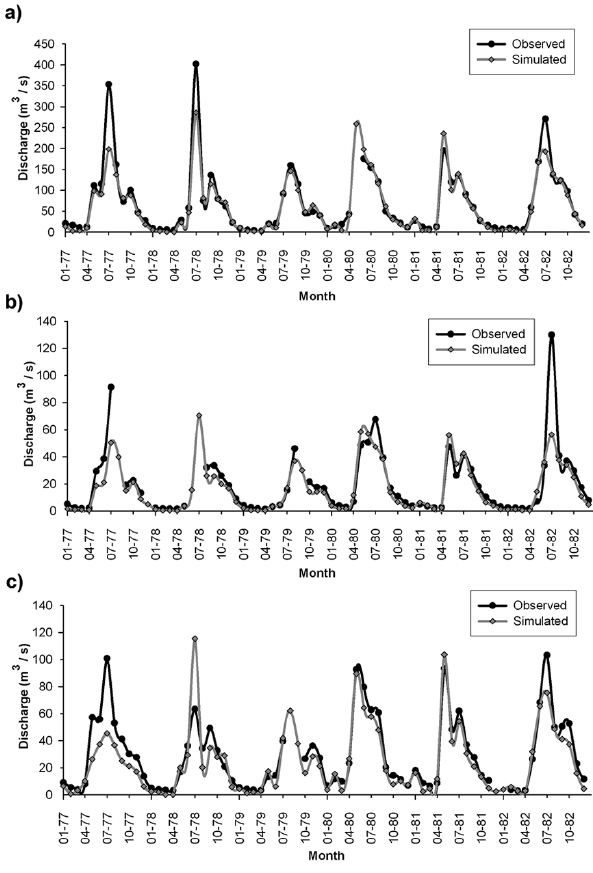
Fig. 9. Observed and simulated mean monthly discharges for the years 1977–1982 at the gauge stations Tijeral (a) , Mininco (b) and Malleco (c)